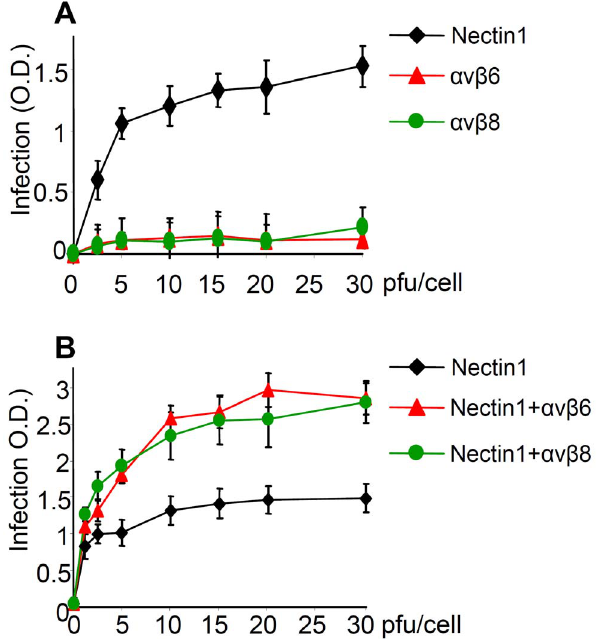
Figure 7. a v b 6 and a v b 8 -integrins do not substitute for nectin 1, yet they increase infection of R8102 in J cells expressing nectin 1 at low level. (A) The receptor-negative J cells were transfected with nectin1 alone, a v b 6-integrin alone, or a v b 8-integrin alone. (B) J cells were transfected with low amount (75 ng DNA/24 well) of nectin1 alone, or with the same amount of nectin1 plus a v b 6-integrin (300 ng DNA/24 well), or plus a v b 8–integrin (300 ng DNA/24 well). 48 h after transfection, cells were infected with R8102, at increasing MOI (2.5–30 pfu/cell) and harvested at 16–18 h after infection. Experimental details as in Fig. 3. Extent of b -Gal activity, measured as ONPG conversion was measured by O.D. reading at 405 nm. Each point represents the average of triplicates. Bars show SD.